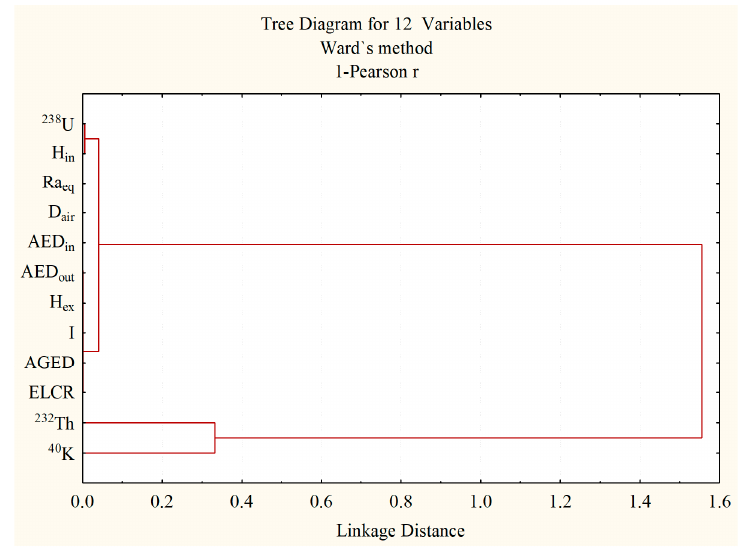
Figure 9. The hierarchical clustering analysis (HCA) of the radiological parameters.